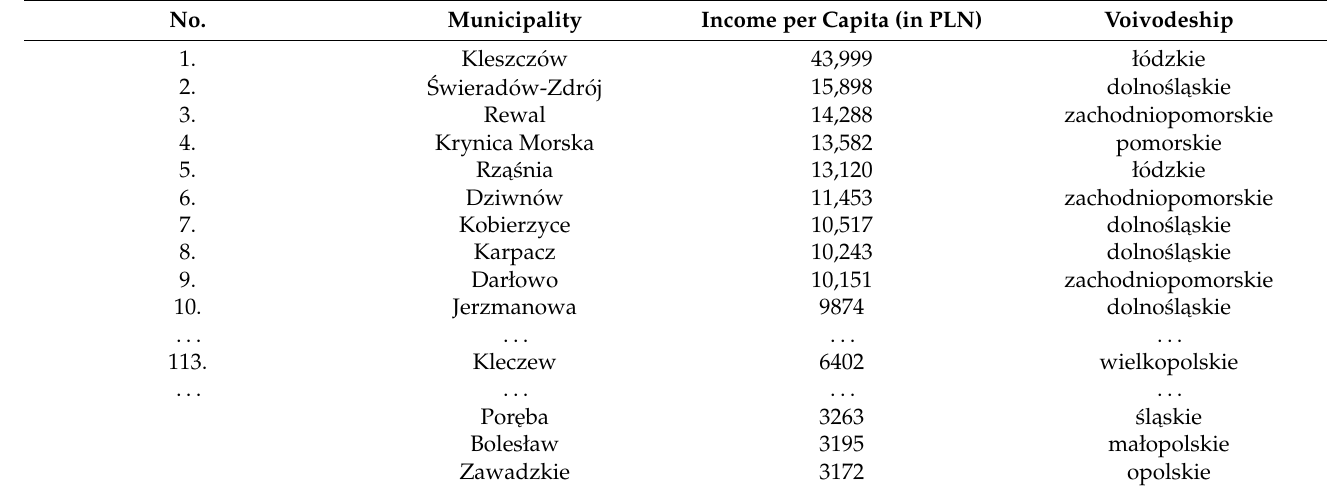
Table 6. Per capita income in selected municipalities in